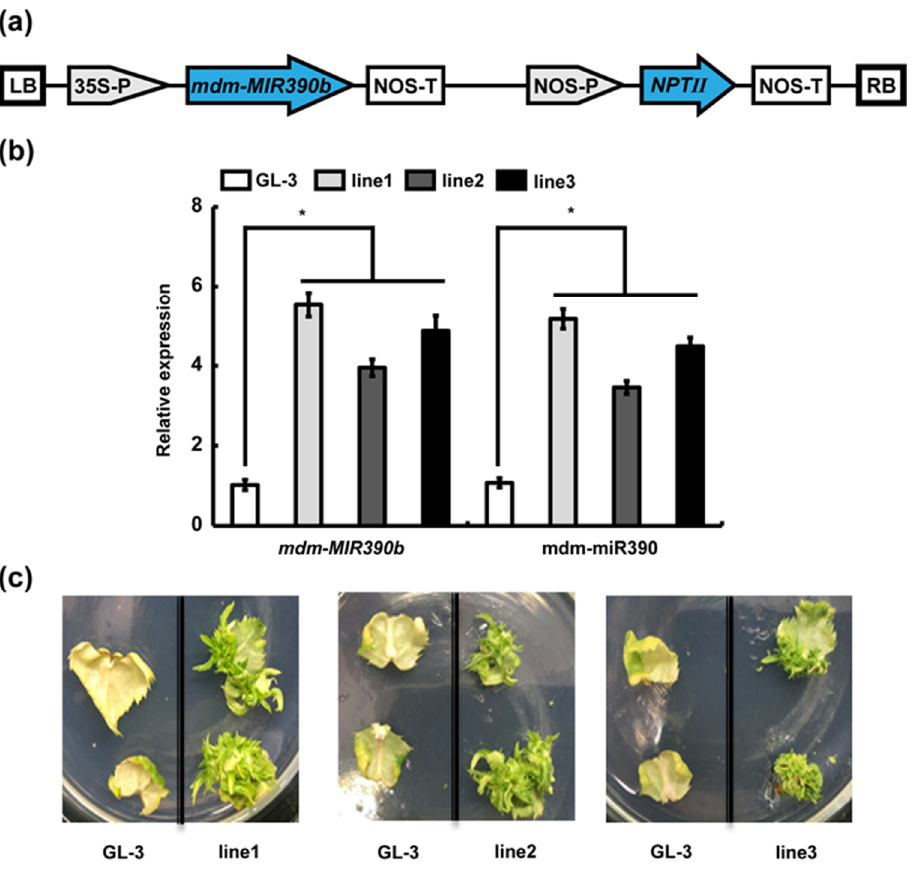
Figure 4. Identification and analysis of transgenic plants. ( a ) Structural diagram of pRI101- MIR390b . ( b ) Expression analysis of mdm-MIR390b gene and mdm-miR390 in ‘GL-3 (cid:48) and MIR390b -overexpressing plants. The vertical bars represent SDs ( n = 3). ‘*’ represents p < 0.05 (Student’s t -test). ( c ) Leaf regeneration observation of ‘GL-3 ′ and MIR390b -overexpressing plants.